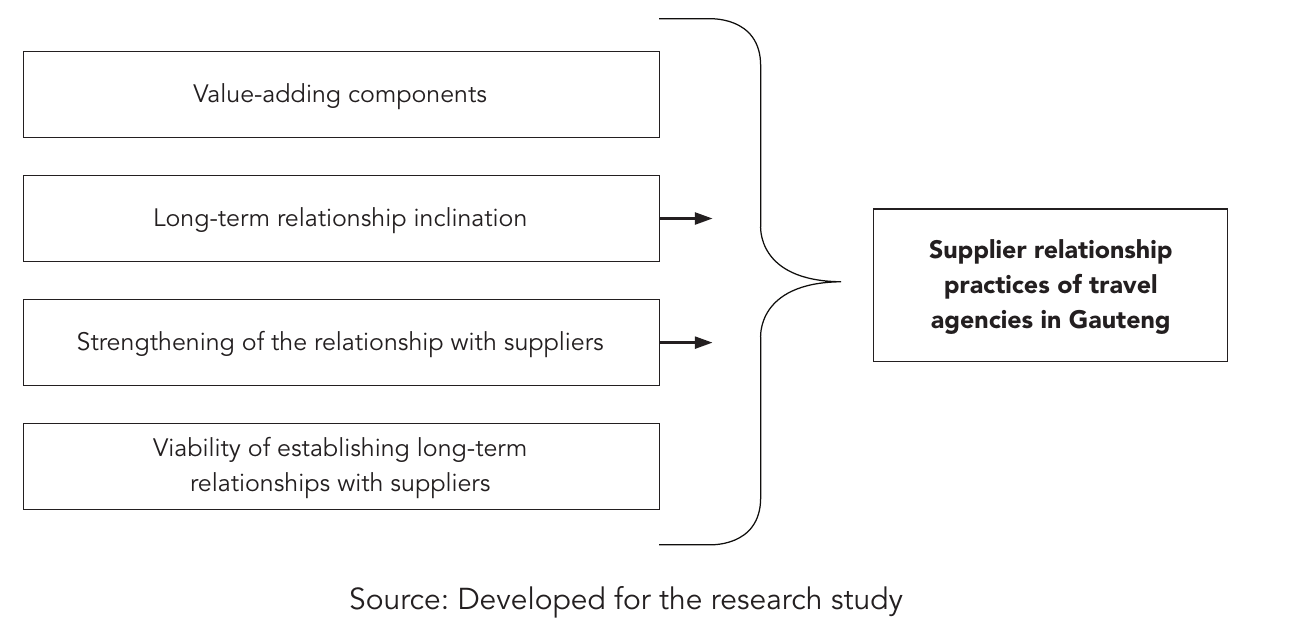
Figure 1: Conceptual framework OBJECTIVES OF THE